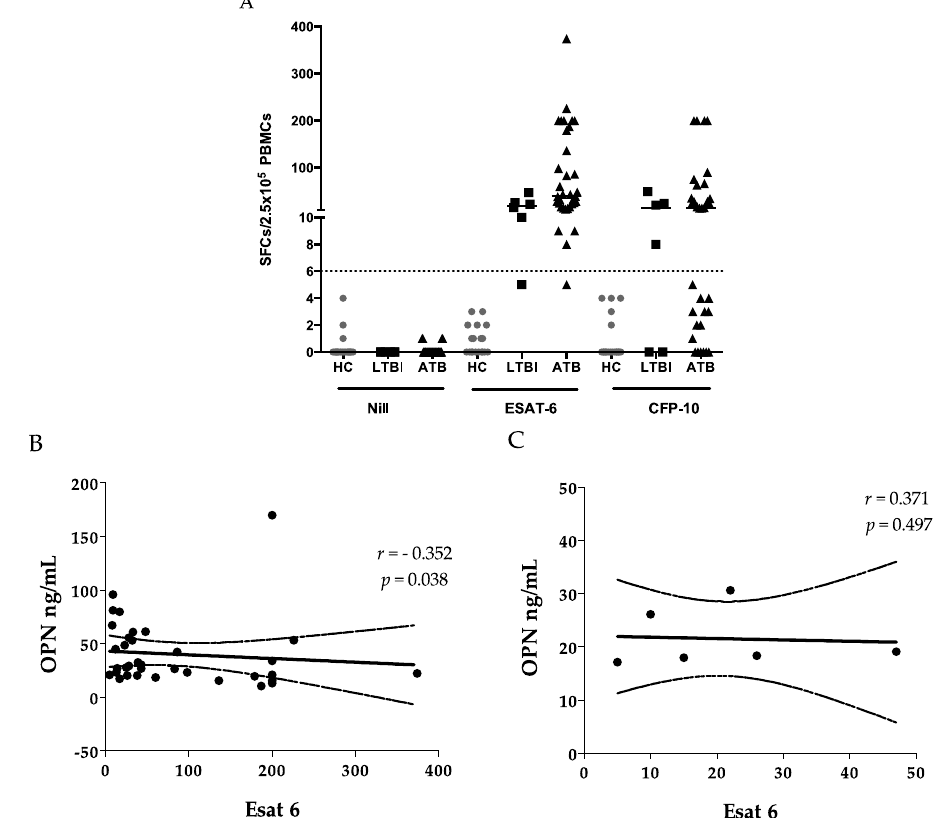
Figure 2. ELISPOTs reaction and OPN levels. ELISPOT assays are plotted as the number of specific PBMCs against the indicated stimulus ( A ); a negative correlation was observed between the ELISPOT for ESAT-6 and OPN in TB ( B ); and this correlation was not seen in the LTBI group ( C ).